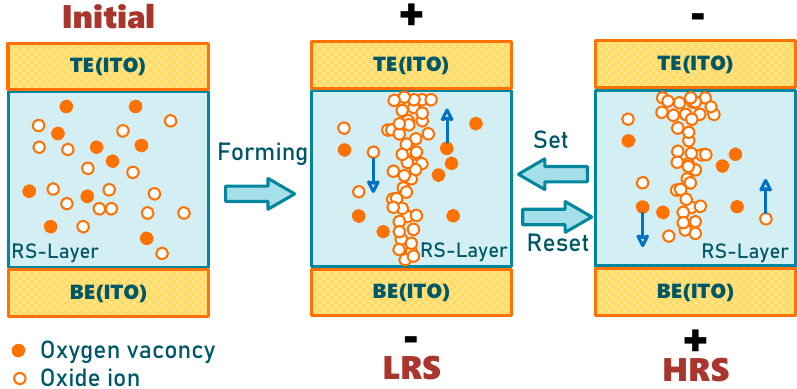
Figure 9. Schematic diagram of resistance switching process of RRAM devices.